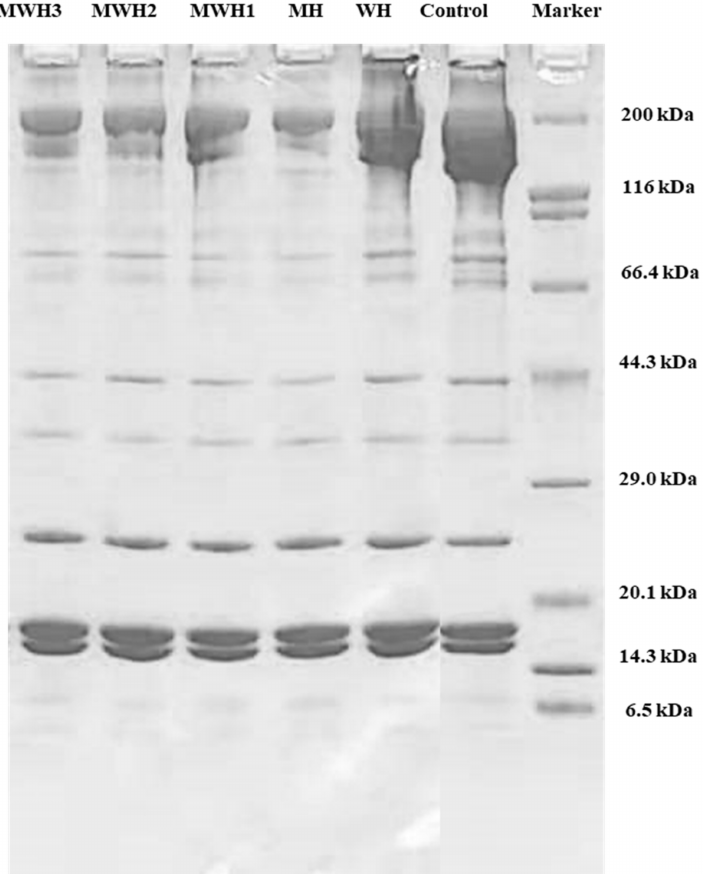
Figure 6. SDS-PAGE patterns of SCM heated by different